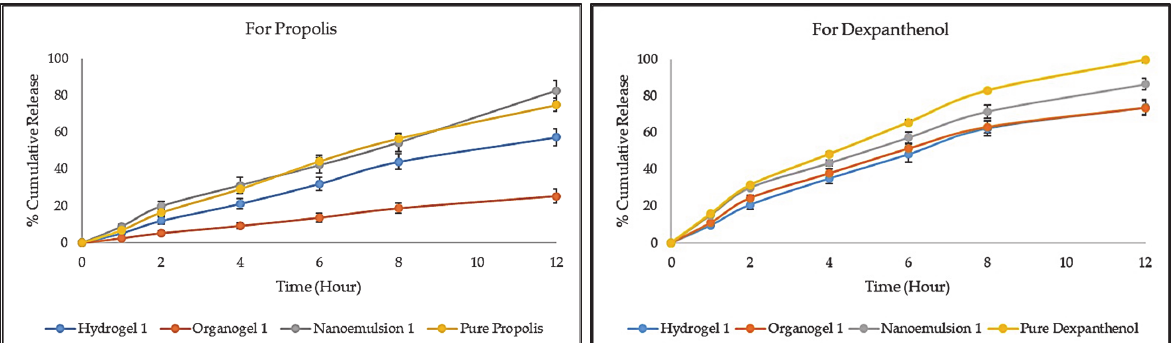
Figure 7. Release profile of propolis and dexpanthenol (mean ± SD).